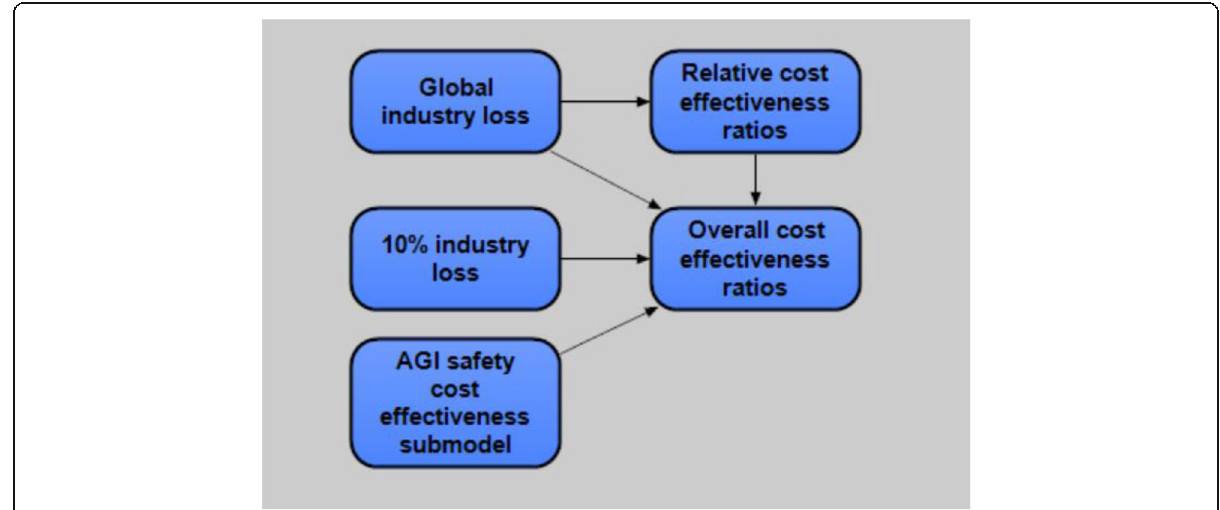
Fig. 2 Model overview